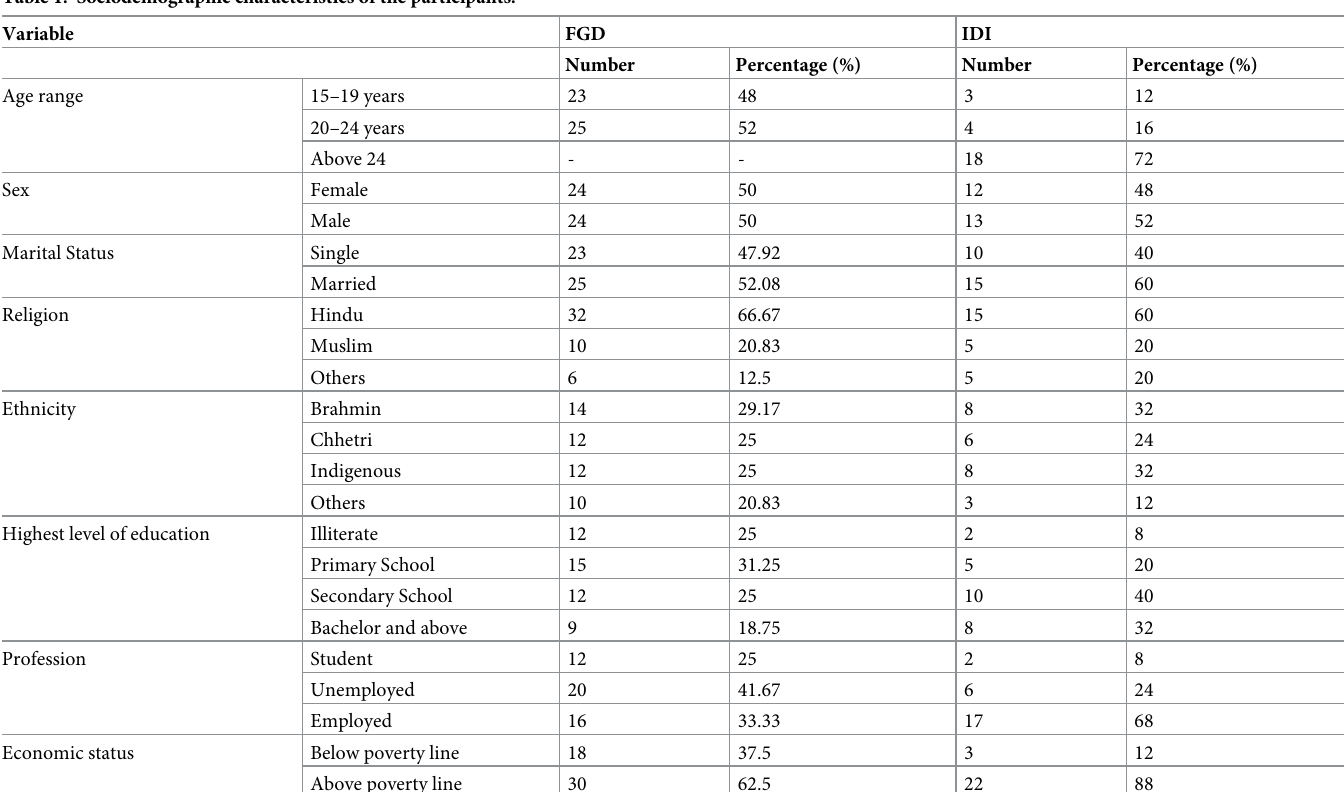
Table 1. Sociodemographic characteristics of the